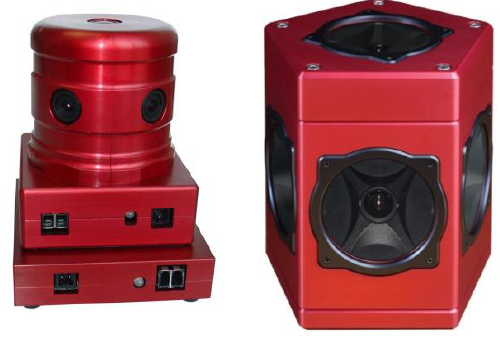
Figure 2 Ladybug 2 (left) and Ladybug 3 (right) – spherical video cameras. Images from: